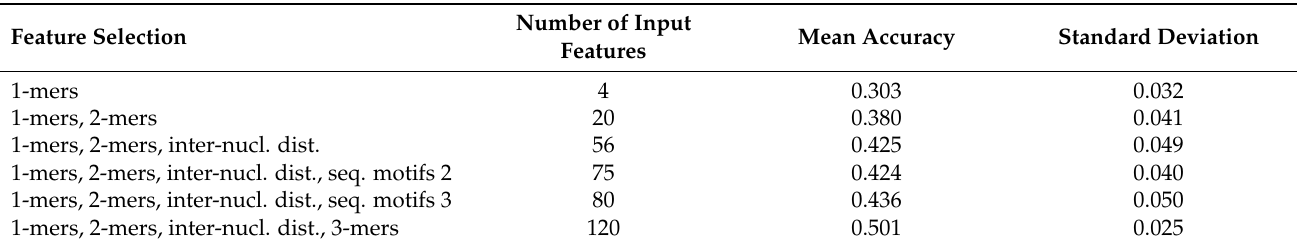
Table 3. Overview on input features for the artificial neural networks. Different combinations k -mers and sequence motifs were evaluated according whether they have significantly different distributions in the nine viral orders. Mean accuracy over 10 simulation runs and standard deviation for the different feature combinations are